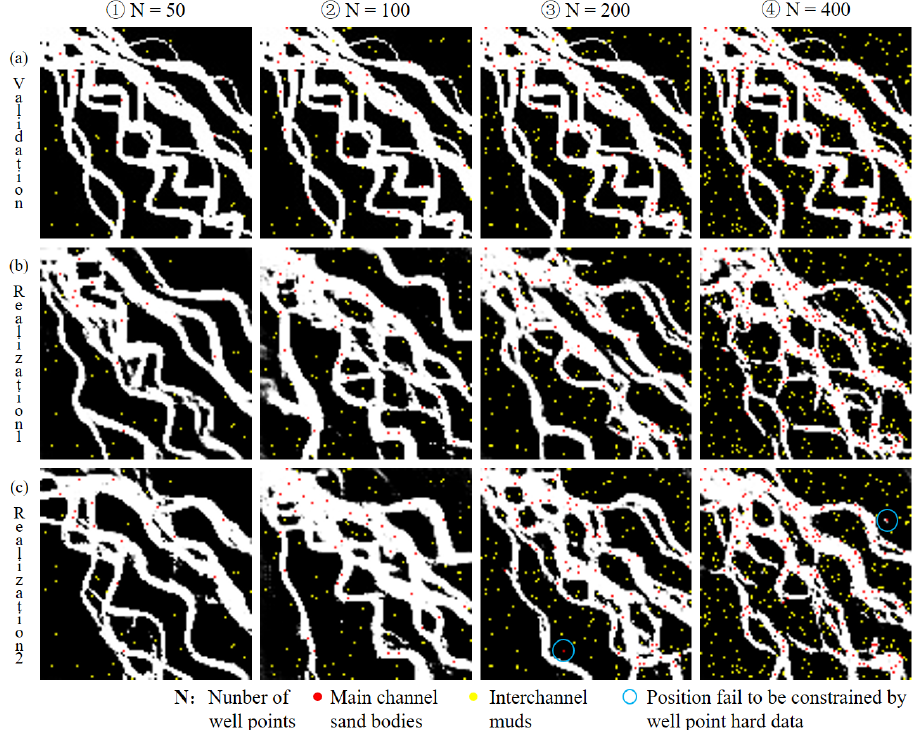
Figure 12. Results of conditional modeling of non-stationary problem (delta plain distributary channel sand bodies). ( a ) The validation model; ( b ) a group of realizations constrained by different number of well points; ( c ) another group of realizations constrained by different number of well points.